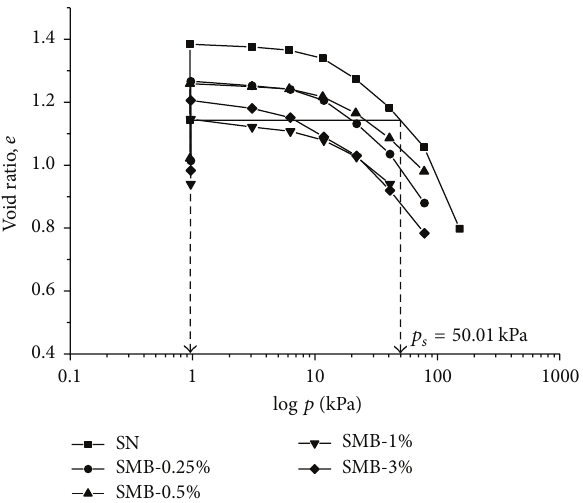
Figure 3: 𝑒 -log 𝑝 curves of soil modified with barb fibers. Table 4: 𝑝 𝑠 and 𝐺 𝑤 values presented by soil modified with barbs. Type of soil